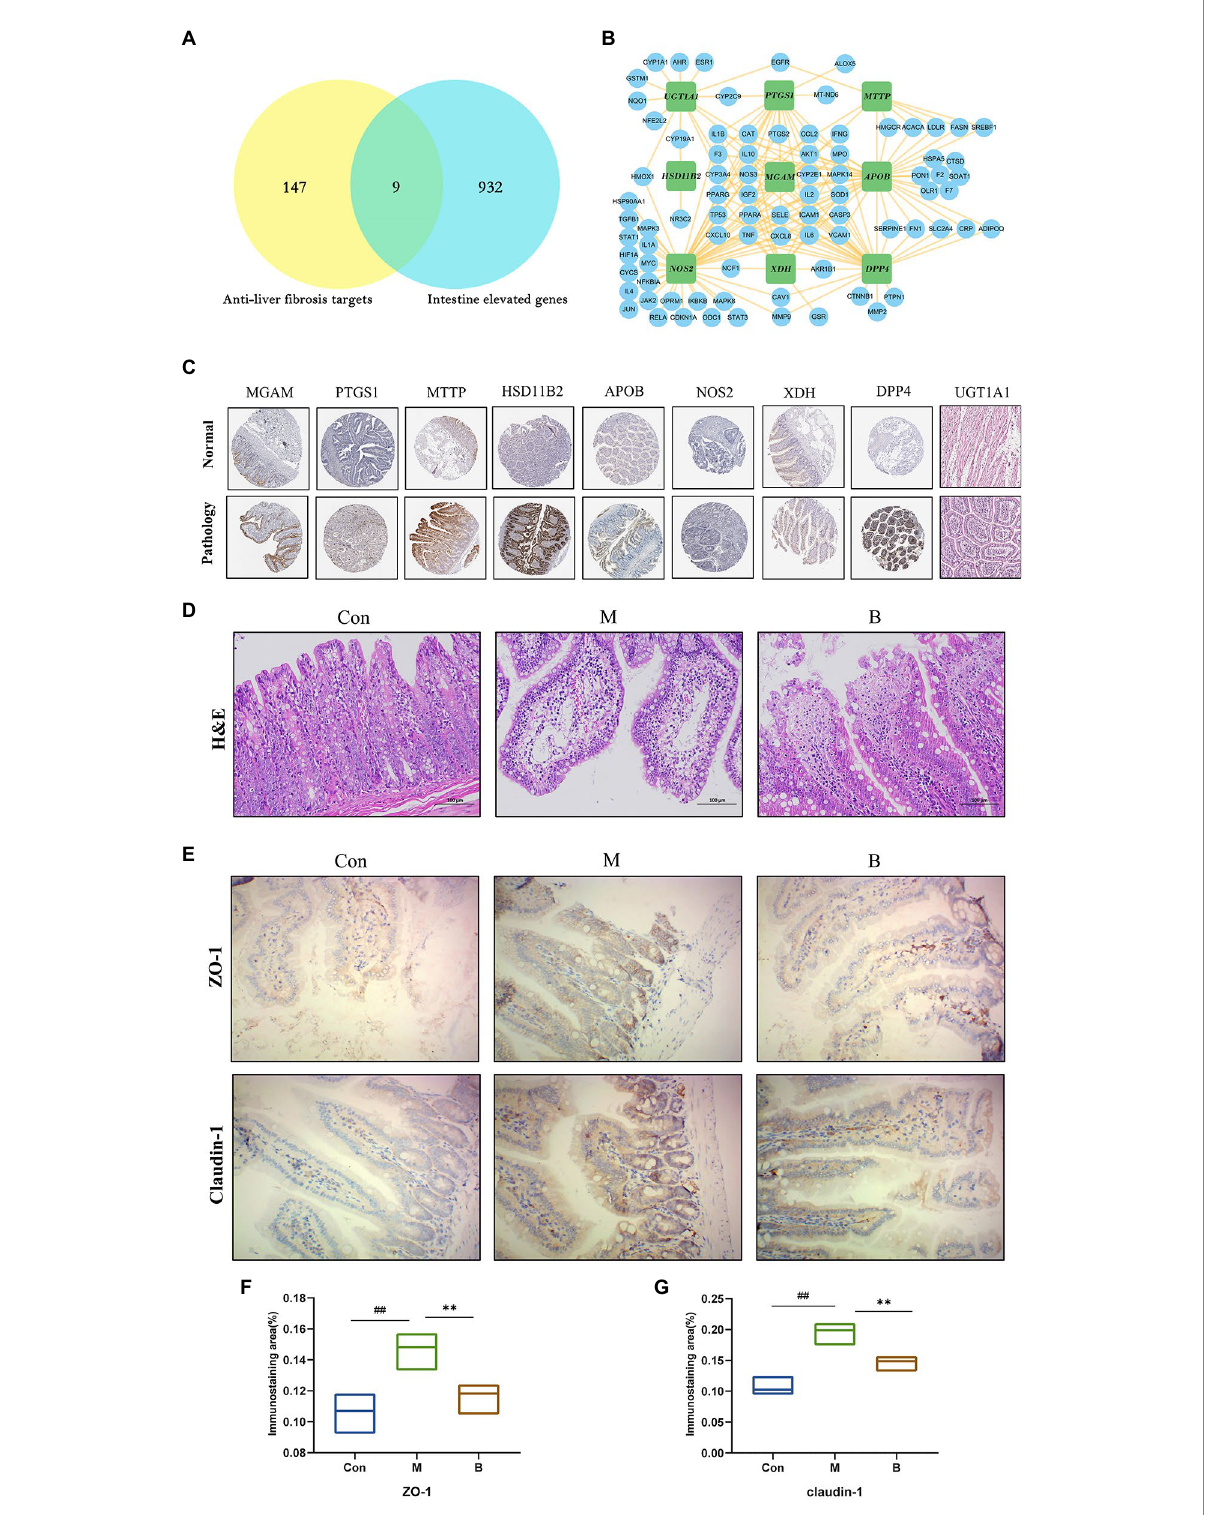
FIGURE 4 Tissue target expression (A) Venn diagram of gut-expressed genes and anti-HF targets. (B) Sub-network of nine targets: PTGS1, XDH, NOS2, DPP, MGAM, MTTP, APO, UGT1A, HSD11B2. (C) On normal and pathological tissues Immunohistochemical staining of nine intestinal abnormally expressed targets. (D) HE staining of the intestinal wall. (E–G) Immunohistochemical staining of intestinal wall permeability; compared with the Con group, # p < 0.05; ## p < 0.01; compared with the M group, * p < 0.05; ** p <